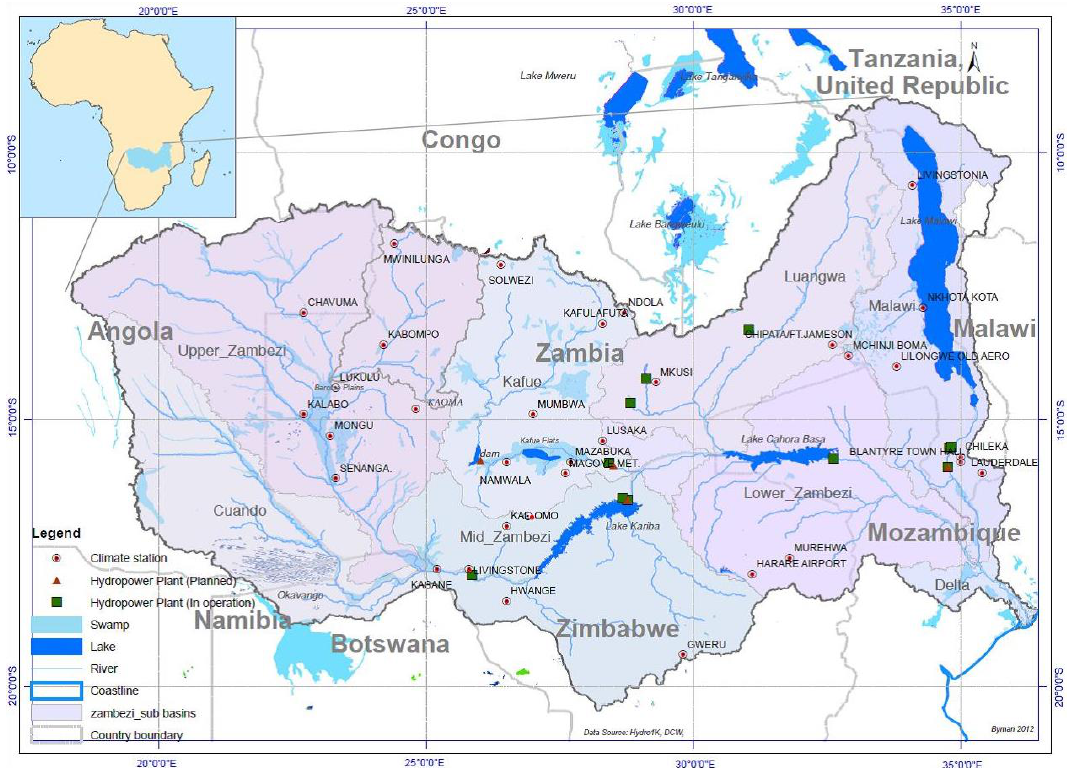
Figure 1. Zambezi River Basin with major sub basins. The red indicates the catchment that contributes to Victoria Falls and the green indicates the catchment that contributes to Kariba hydropower plants.